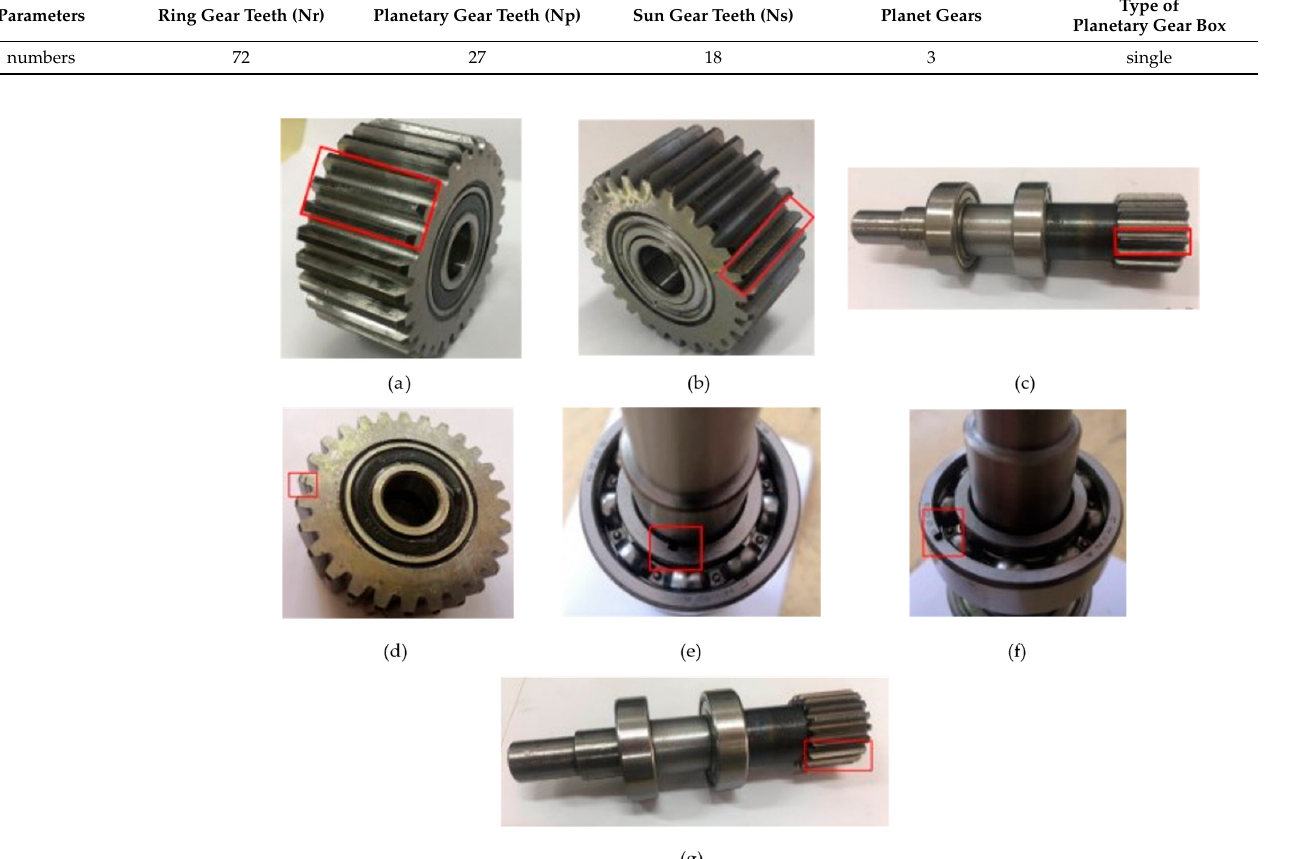
Figure 6. Gears and bearings with different defects. ( a ) Gear pitting ( b ) Gear wear ( c ) Sun gear broken teeth ( d ) Gear crack ( e ) Inner race defect ( f ) Outer race defect ( g ) Sun gear wear.